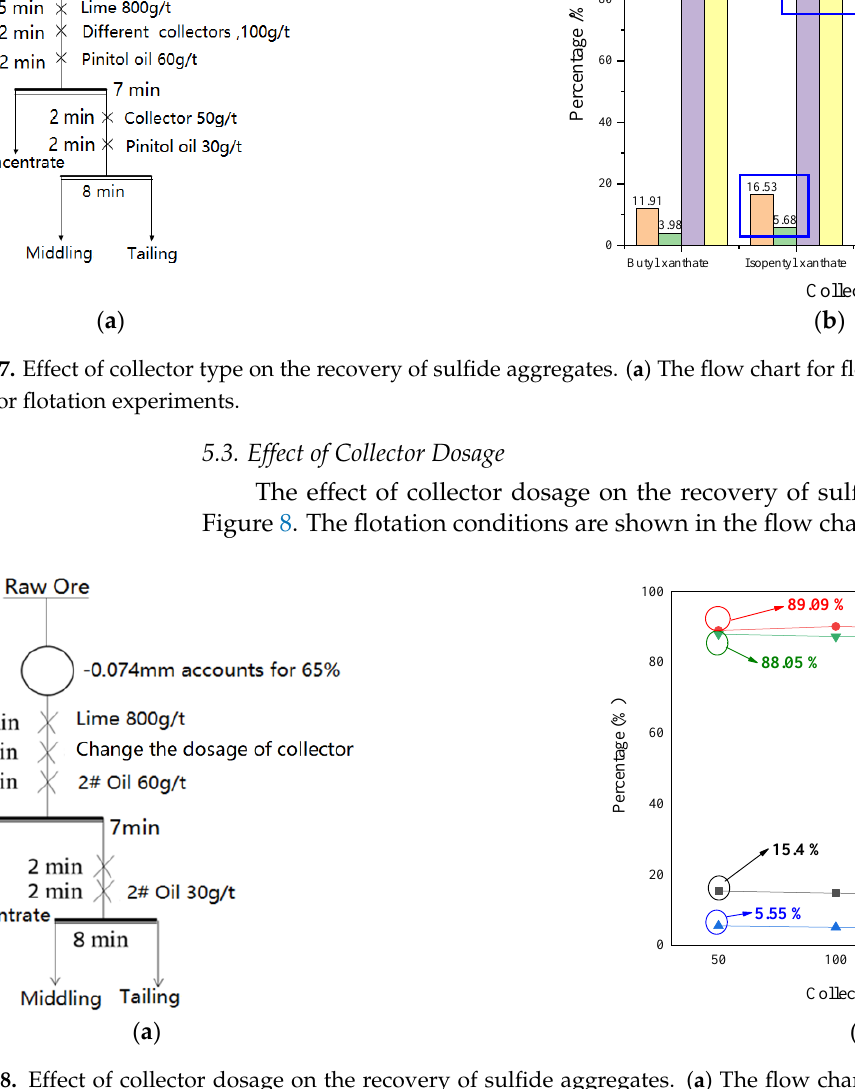
Figure 8. E ffect of collector dosage on the recovery of sulfide aggregates. ( a ) The flow chart for flotation experiments ( b ) Effect of collector dosage on the flotation recovery. The grades and recoveries of Cu and Co changed only slightly as the collector dosage increased from 50 g·t −1 to 200 g·t −1 . Given the recovery value of metals, Co was prioritized